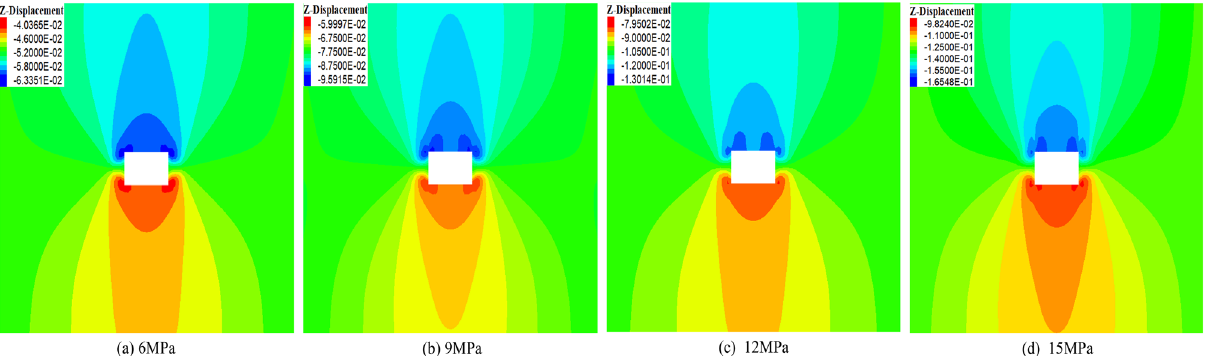
Figure 3. Deformation of surrounding rock under different disturbance intensities.